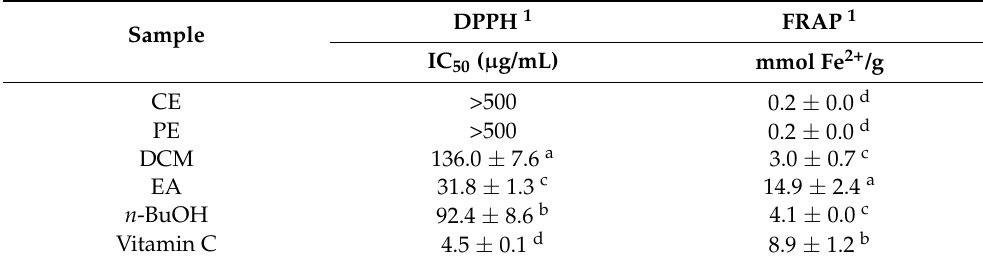
Table 1. Antioxidant activities of different extracts of C. spinarum tested by DPPH and FRAP assays.